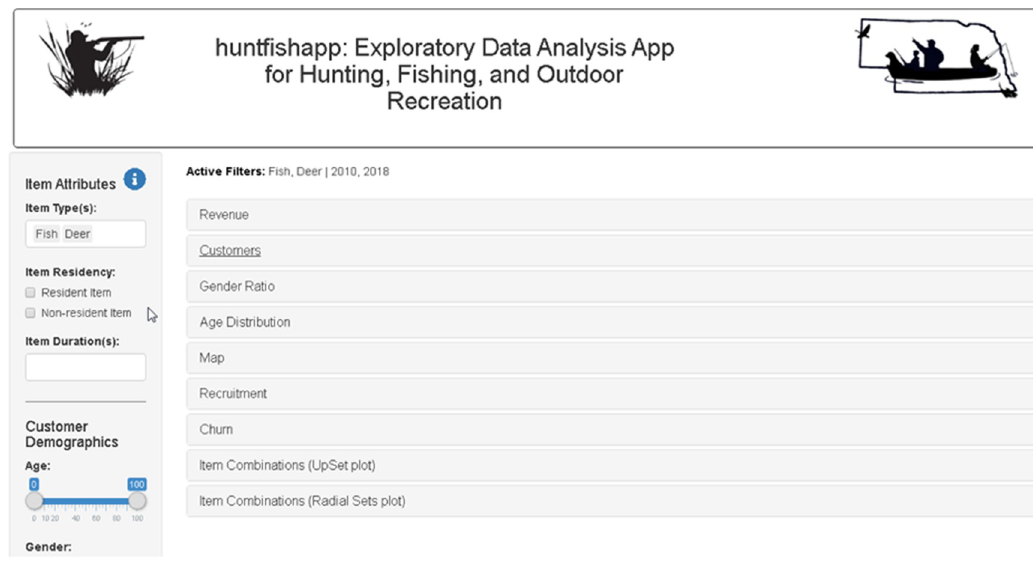
Fig 2. The app layout consists of a sidebar with data filters on the left and collapsible panels on the right.